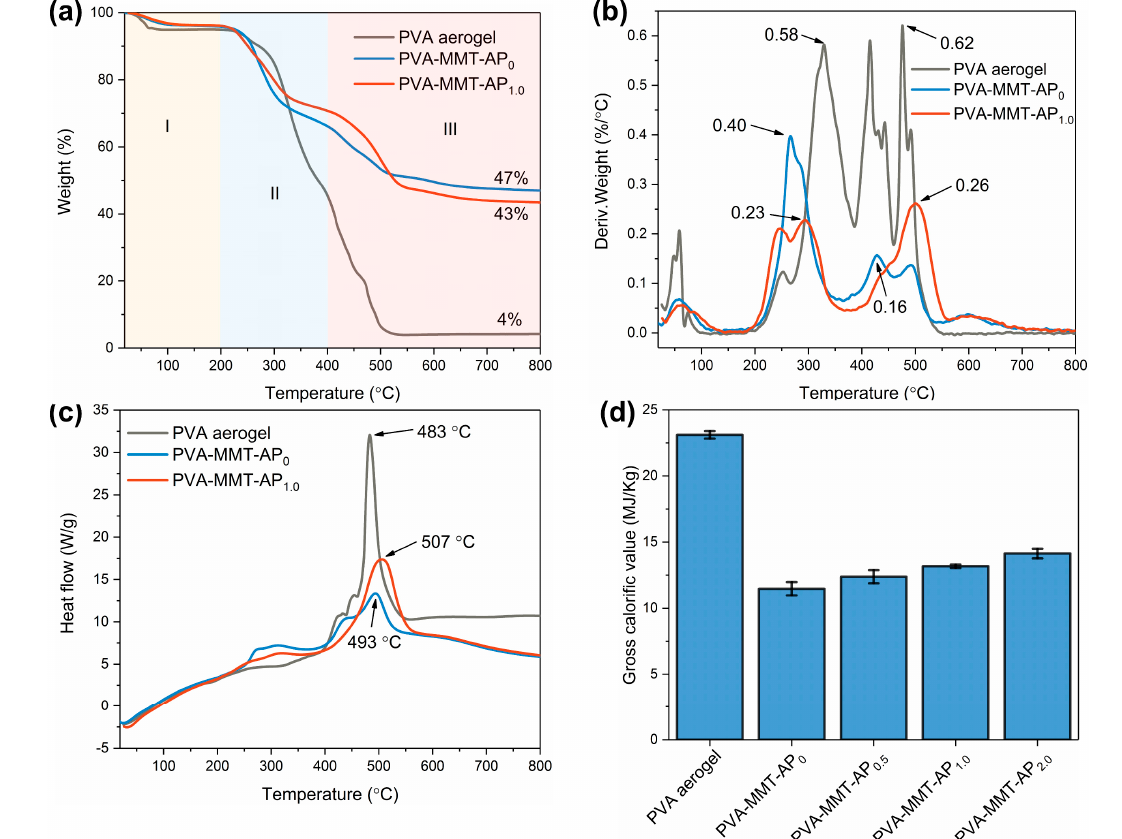
Figure 6. ( a ) TG, ( b ) DTG and ( c ) DSC curves of the pure PVA aerogel, PVA-MMT-AP 0 and PVA- MMT-AP 1.0 . ( d ) The gross calorific values of the pure PVA aerogel and PVA-MMT-AP x . Table 1. The temperatures at the maximum decomposition rates (T max ), the maximum thermal decomposition rates (dW/dT) and the residues of the pure PVA aerogel, PVA-MMT-AP 0 and PVA- MMT-AP 1.0 . T max ( ◦ C) dW/dT (%/ ◦ C) Samples Residue (%) Stage II Stage III Stage